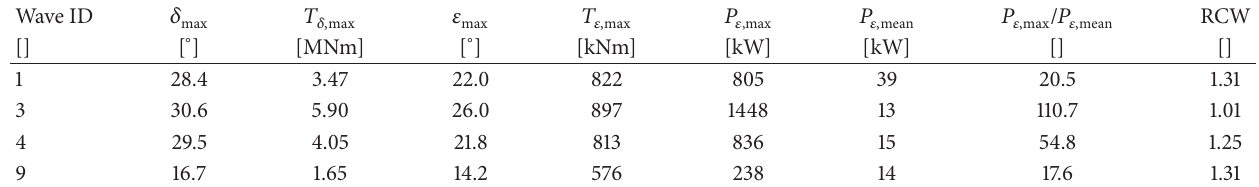
Table 4: Results for the optimal stochastic control with no